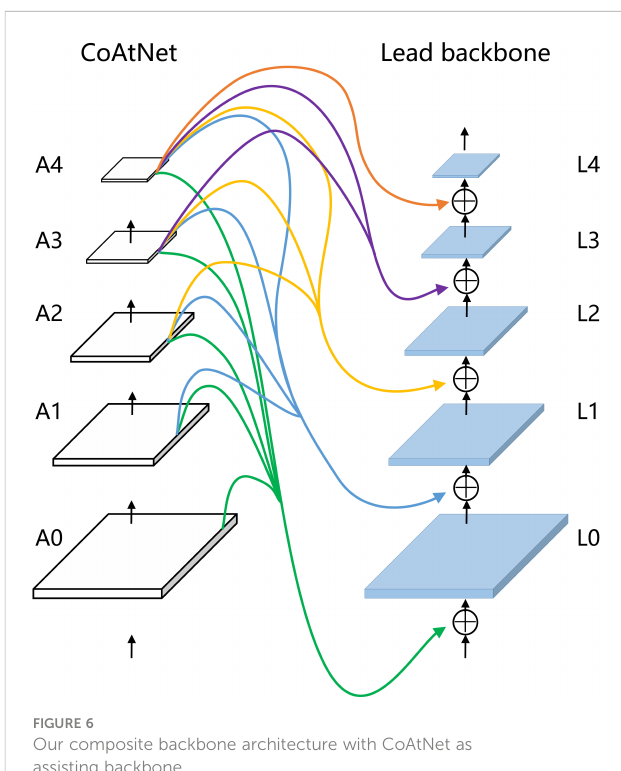
FIGURE 6 Our composite backbone architecture with CoAtNet as assisting